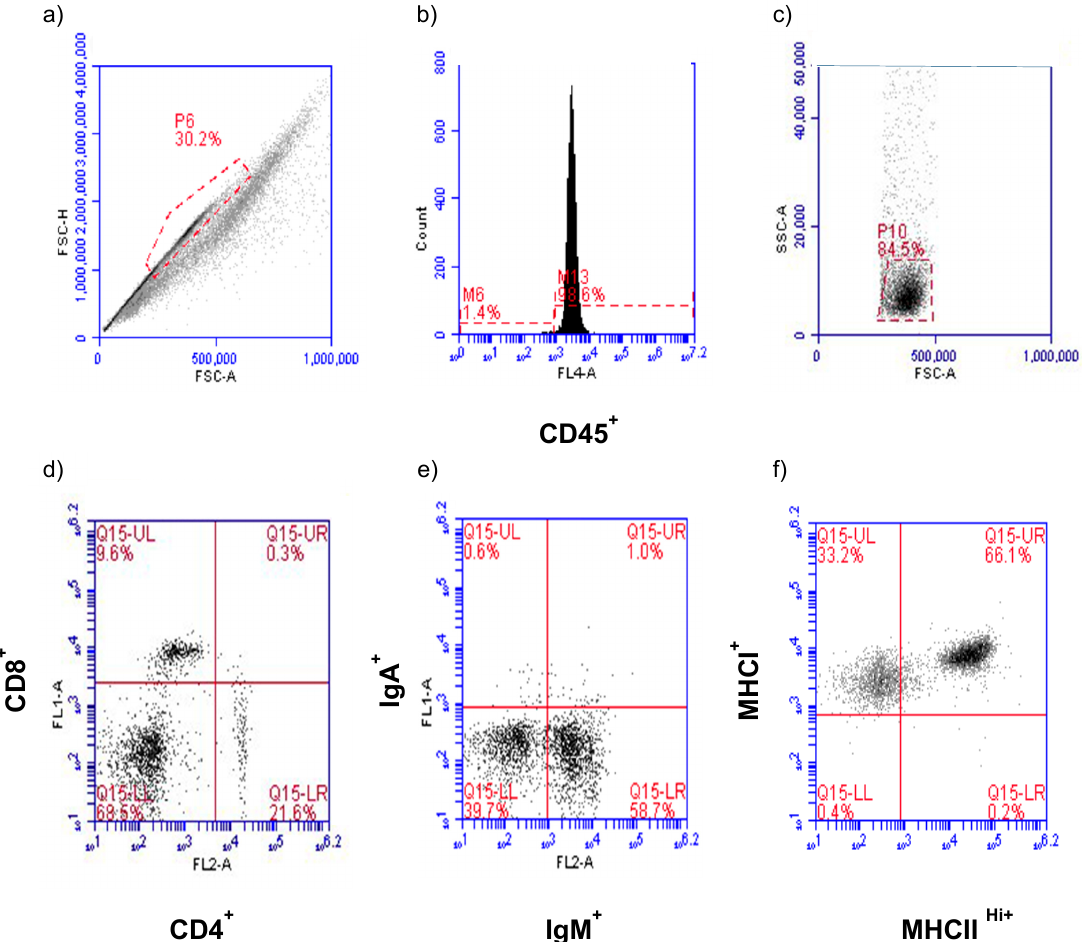
Figure 1. Gating strategy of the lymphocyte population. Primary gating was based on size consistency and single cell using forward scatter height versus forward scatter area (FSC-H vs. FSC-A) ( a ) and subjected to CD45 assessment ( b ). Representative flow cytometric forward-angle and right-angle scatter (FSC-A vs. SSC-A) gated on only CD45 + cells were used to identify the lymphocyte population ( c ). The CD45 + lymphocytes population was subjected to CD4 + and CD8 α + ( d ), IgM + and IgA + ( e ), MHCI + and MHCII Hi + ( f ) assessment.